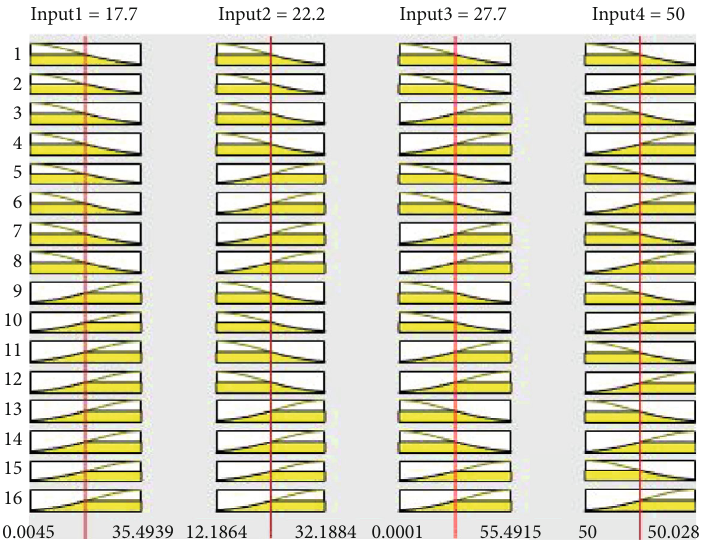
Figure 2: Fuzzy rules.